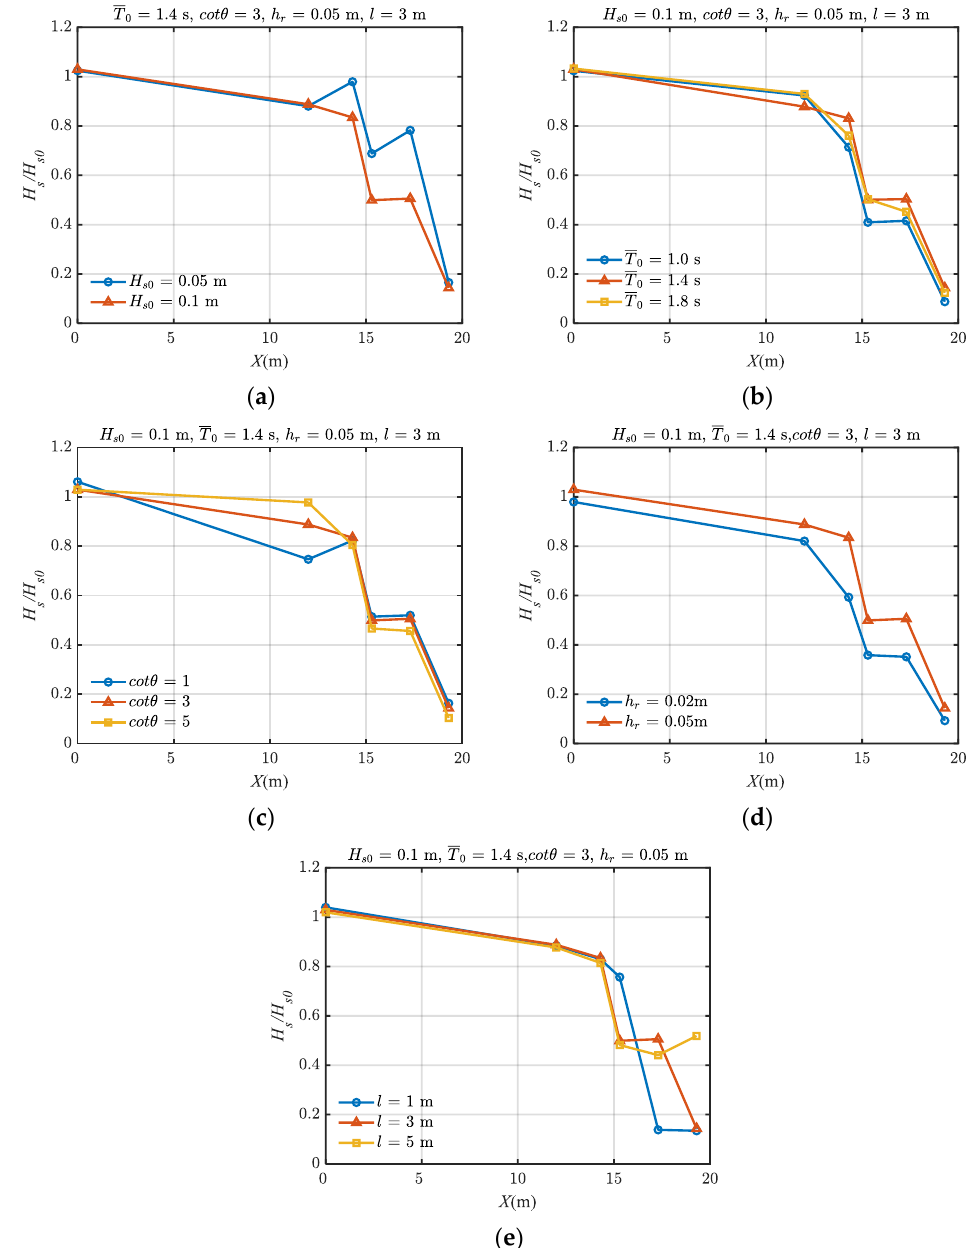
Figure 9. Irregular wave height transformation for the vertical seawall on the reef flat for different cases: ( a ) H s 0 ; ( b ) 0 T ; ( c ) cot θ ; ( d ) h r ; ( e ) l . cases: ( a ) H s 0 ; ( b ) T 0 ; ( c ) cot θ ; ( d ) h r ; ( e ) l